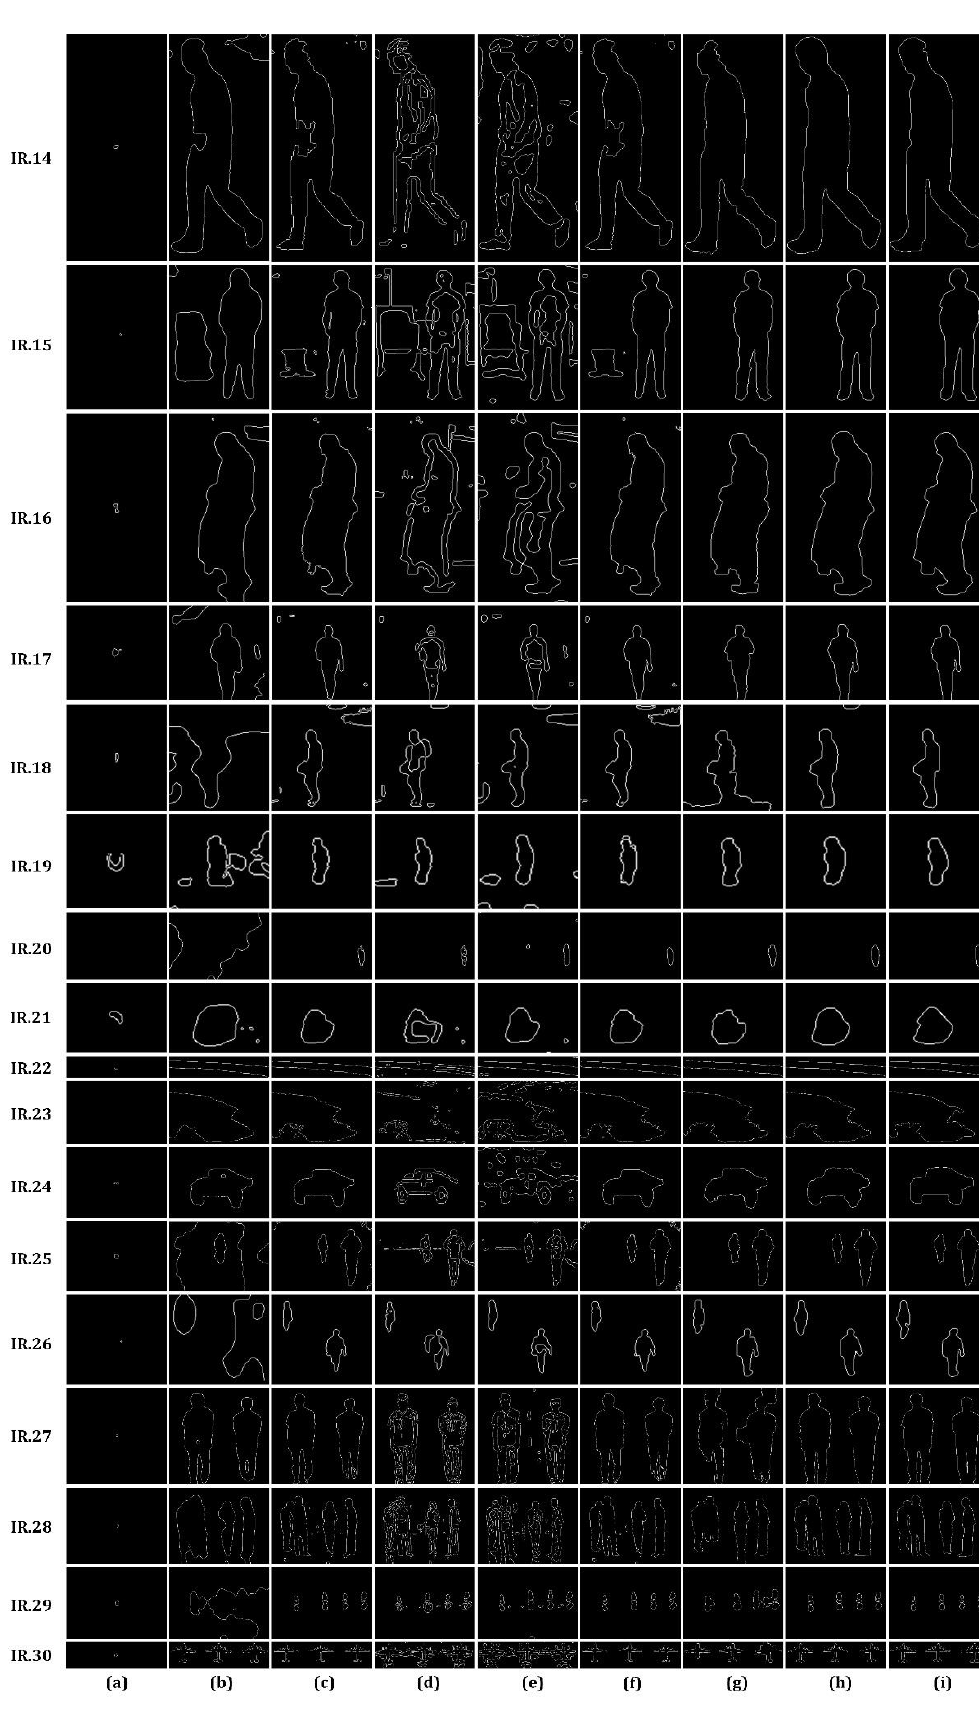
Figure 13. Boundary maps of IR image database: ( a ) GAC; ( b ) CV; ( c ) SBGFRLS; ( d ) LBF; ( e ) ILFE; ( f ) Cao’s model; ( g ) MSRM; ( h ) the proposed method; ( i ) ground truth.